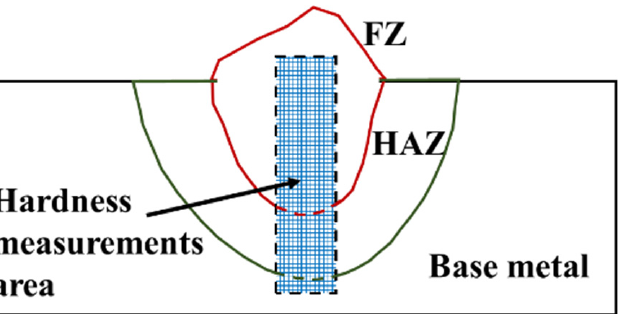
Figure 4. Schematic representation of hardness impressions of the weld bead. Where: heat-affected zone (HAZ) and fused zone (FZ).